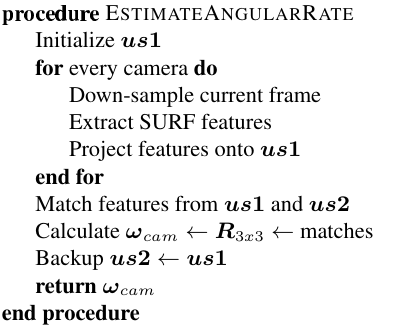
Figure 6: Basic algorithm to estimate the angular rate ω cam with the multi camera rig. The features of the current camera frames are projected onto the first unit sphere us 1 , whereas the features from the previous time step are available in us 2